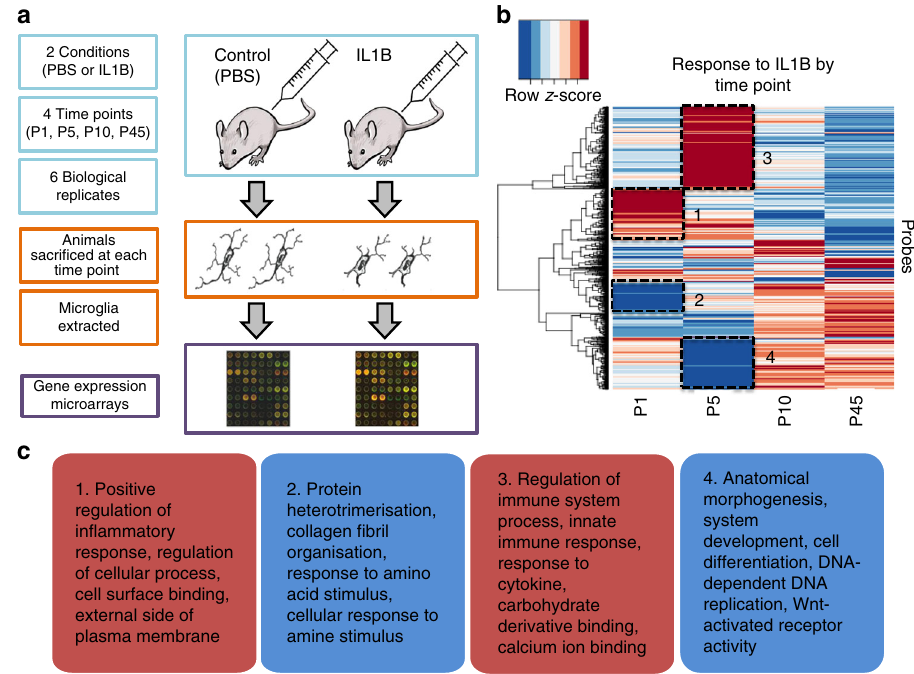
Fig. 1 Overview of in vivo mouse model, and clustering of expression responses to IL1B by time point, with functional annotation summary. a IL1B mouse model experimental set-up. b Clustering of expression pro fi les in response to IL1B, showing up- and downregulated clusters at each time point (Student ’ s t test, p < 0.05, FDR 10%). c Summary functional annotation of four main clusters identi fi ed in b . Red = upregulated in IL1B vs. PBS, Blue = downregulated in IL1B vs. PBS. Mouse illustration: “ Drawing of a grey mouse ” , Author Jan Gillbank, licence CC-BY-3.0. Syringe icon made by Freepik from www. fl